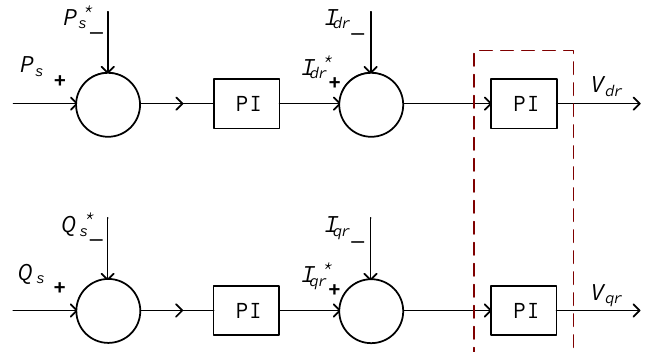
Figure 2. RSC control loops: stator real power ( top loop), and stator reactive power ( bottom loop). Reference values labeled with